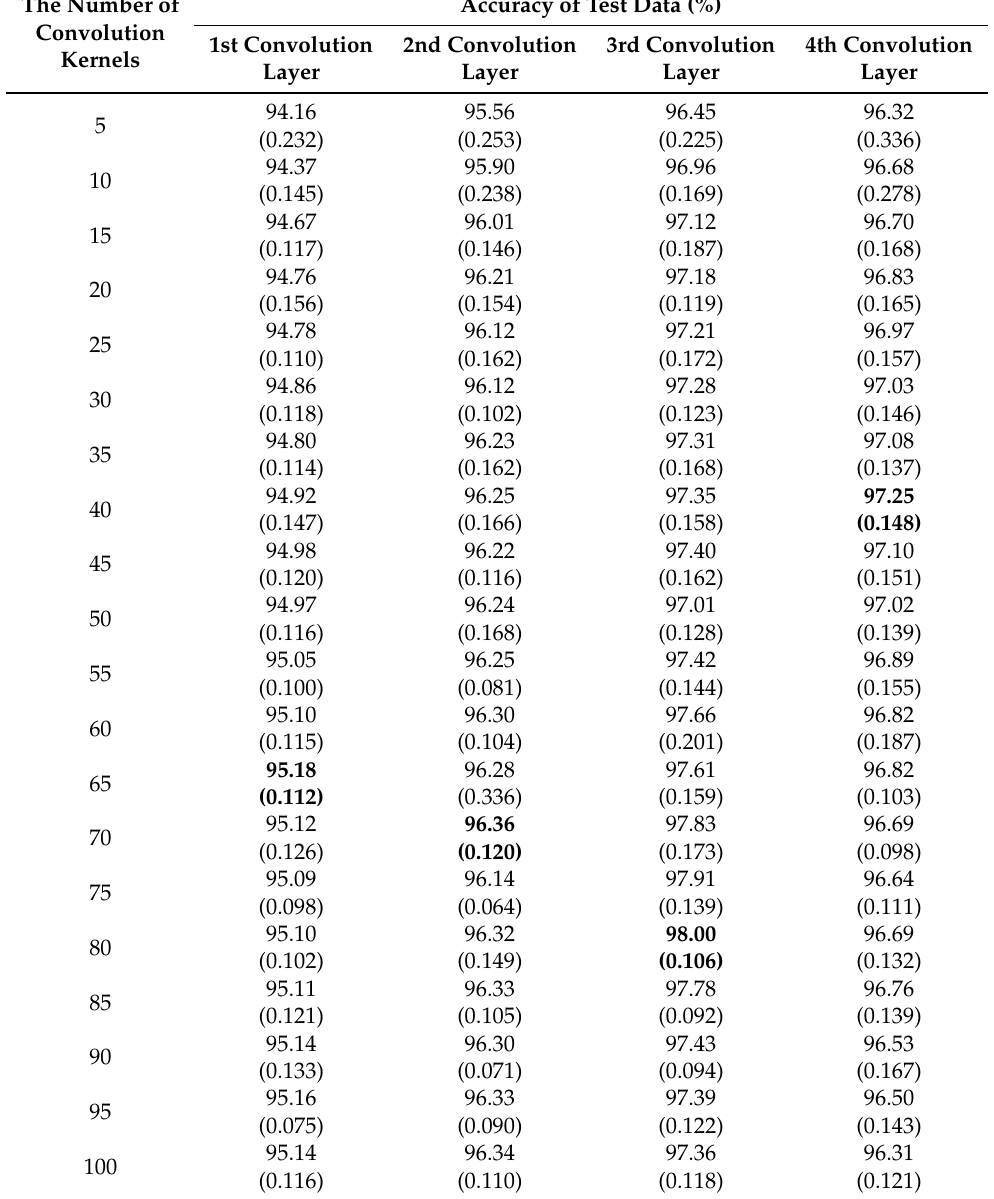
Table 1. The recognition accuracy comparison among different number of layers and convolution kernels. The boldface entries represent the highest average accuracy under the current layer. Numbers in parentheses are standard deviation of recognition